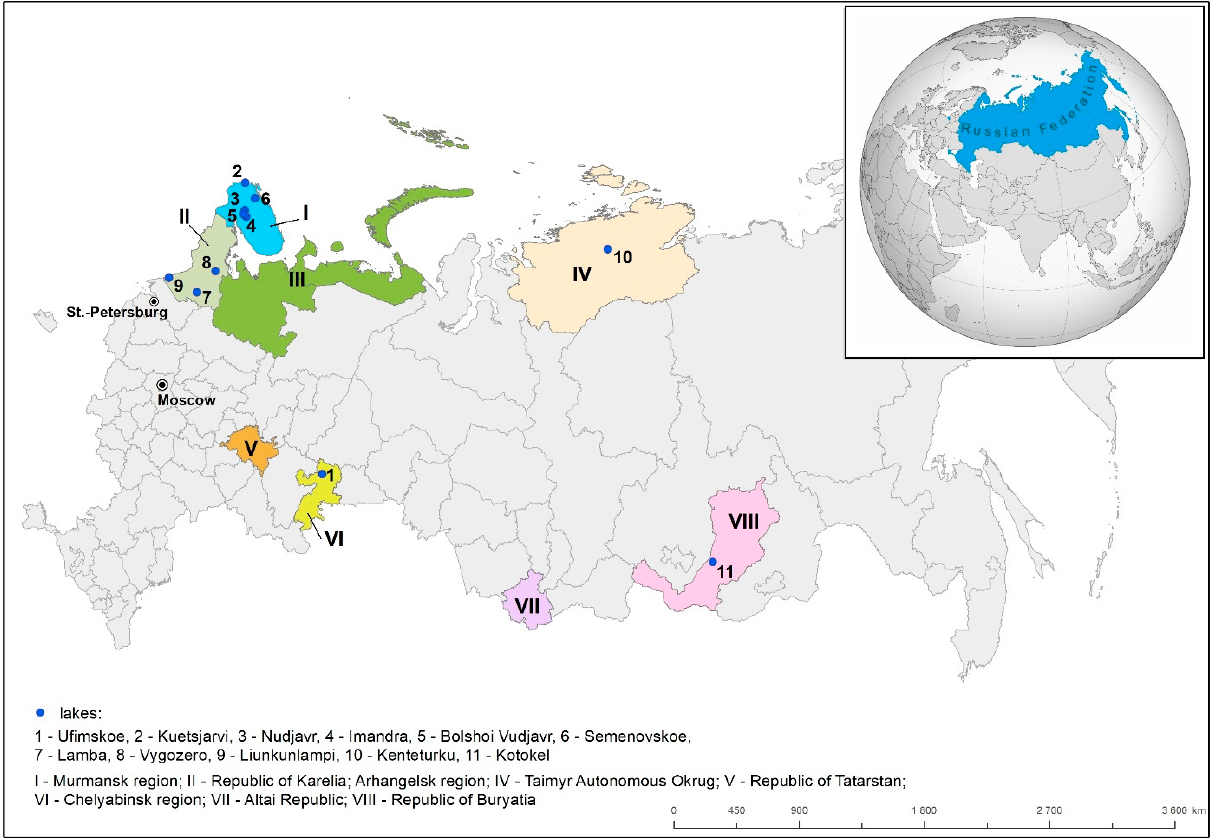
Figure 1. A map with the designation of lakes and key regions of paleolimnological studies. The main characteristics of water bodies from the map are in Table 1.